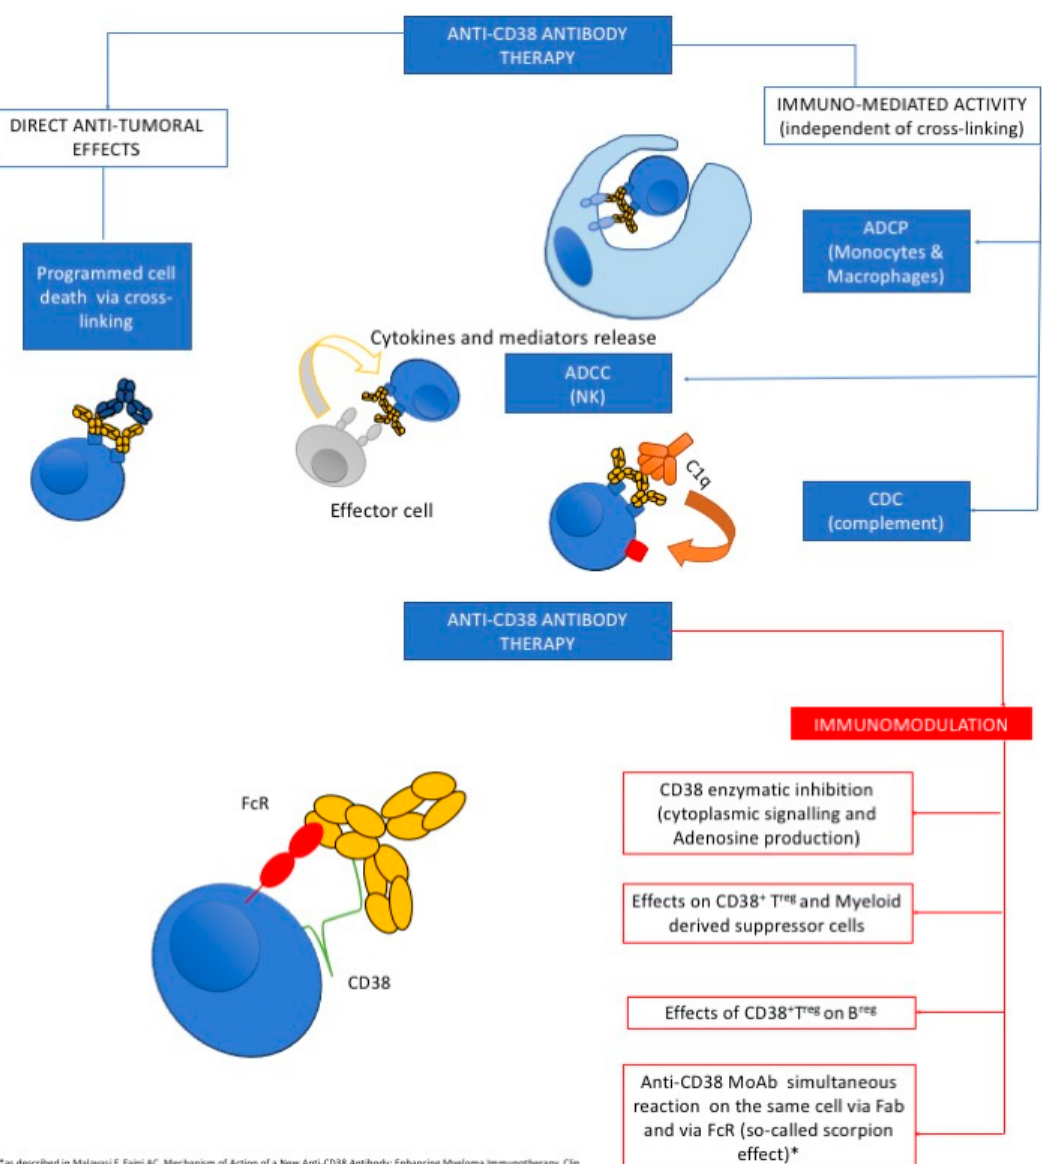
Figure 1. (UPPER PANEL) The left side of the figure illustrates the key e ff ects of the anti-CD38 antibodies on the tumor target and on the main functional e ff ector cells. On the right, a diagram of a hypothetical extension of the immunomodulatory e ff ects mediated by anti-CD38 antibodies. The most intriguing hypothesis is based on the functional synergic interactions between the antibodies and their IgG Fc receptors expressed at various levels by myeloid and lymphoid e ff ectors. The diagram (LOWER PANEL) also shows that the anti-CD38 antibodies may react simultaneously on the same cell via Fab and via FcR, through the so-called scorpion e ff ect [54].